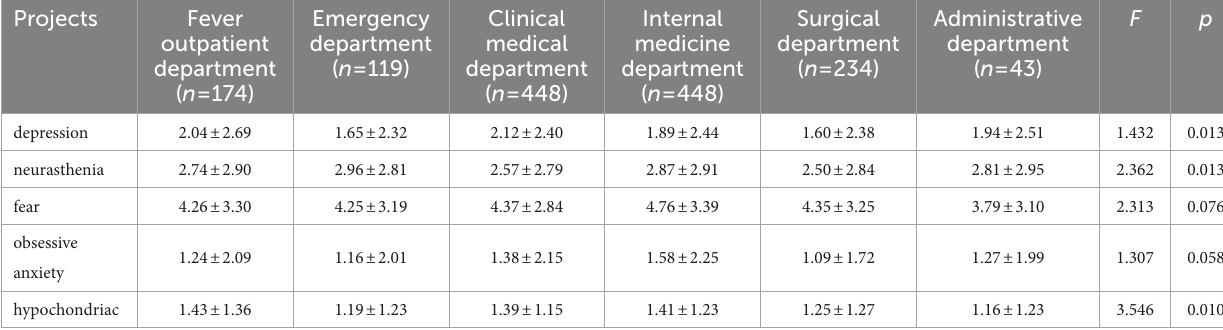
TABLE 4 Comparison of emotional dimensions of staff in different departments.